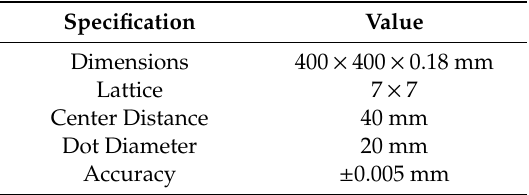
Table 6. The specifications of the dot calibration